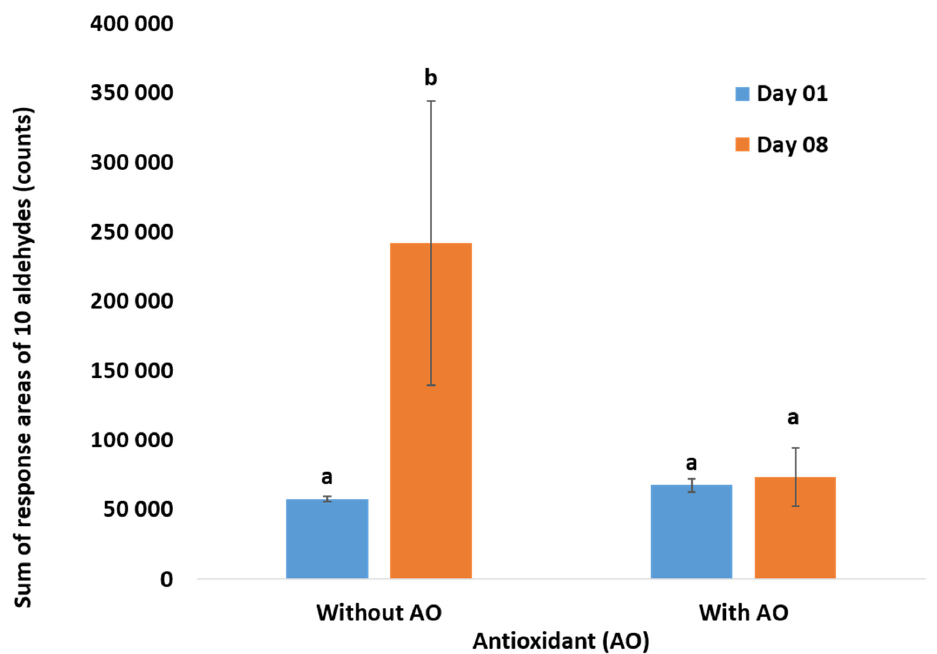
Figure 3. Impact of citric acid, lecithin, and ascorbyl palmitate on the sum of volatiles (responses area) determined by SPME-GC-MS in a liquid infant milk formula. AO means antioxidants and corresponds to the mixture of citric acid, ascorbyl palmitate (E304), and lecithin (use to present an antioxidant activity). The emulsion is stabilized by milk protein. Infant milk formula with antioxidants and without antioxidant (no additives) was stored for 8 days at 70 °C. Values are means and errors bars are standard deviation of three repetitions. Means with different letters are significantly different (one-way ANOVA p < 0.05; factor: storage time (days)) The selected antioxidant mixture proved its efficiency even at elevated temperatures. Though lecithin is not classified as a metal ions chelator, or a radical scavenger, it is known for its antioxidant activity. Lecithin’s antioxidant activity can be related to its synergy with other antioxidants (e.g., tocopherols) [54–56]. Citric acid chelates iron and retards lipid oxidation [57]. Ascorbyl palmitate has the ability to react with oxygen, scavenge radicals (excited dioxygen, O 2 e.g., or two ROO), and act in synergy with other antioxidants, for example, by regenerating tocopherol radicals in tocopherols [11,58]. In addition, the added mixture not only combined different antioxidant strategies but also had different sites of action: citric acid in the aqueous phase, ascorbyl palmitate in the oil phase, and lecithin at the interface and in the aqueous phase (in micelle state when its concentration is over the critical micelle concentration (CMC)). In conclusion, when the antioxidant mixture was added, slight changes were occurring in the volatiles’ content even at high temperature. These results confirmed that the variations identified during storage are mainly related to lipid oxidation and not to protein’s reaction with reducing sugars (Maillard reactions) or sugar crystallization. 3.2. Infrared Spectroscopy in Mid-Region ATR-FTIR Applied to Infant Milk Formulas 3.2.1. Spectral Changes in Infant Milk Formulas The FTIR spectra of infant milk formulas were recorded in the range of 4000–400 cm − 1 . The same absorbance bands were observed for both formulations under different storage conditions. However, changes were noticed after one and six days of storage for samples without and with antioxidants, respectively (Supplementary Materials Figure S3). Attenuation of the bands was more pronounced at higher temperature (70 °C). Figure 4 shows an overlay of the ATR-FTIR spectra of the No-AOx